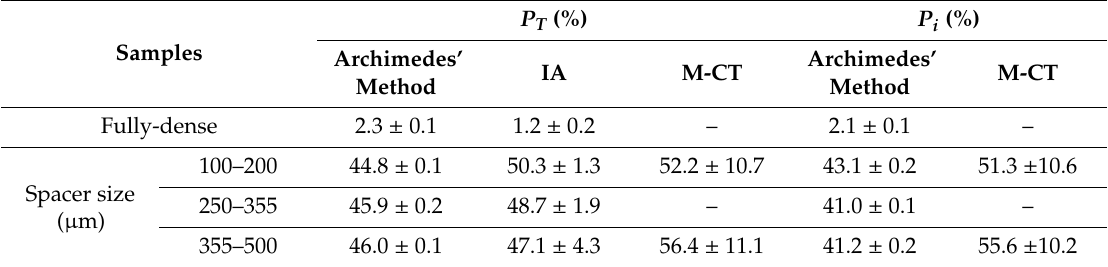
Table 1. Total, interconnected, and isolated porosity evaluated by di ff erent characterization techniques.